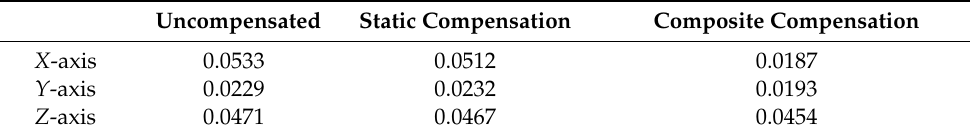
Table 3. The RLG’s bias before and after temperature compensation